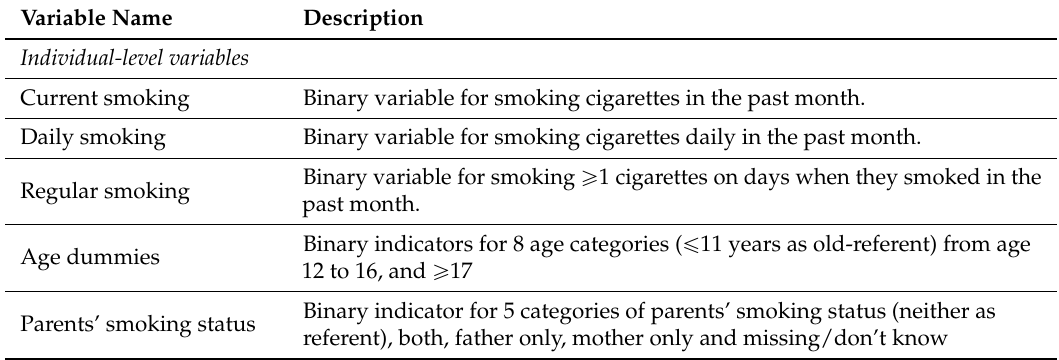
Table 1. Variable definition: Individual-level smoking outcomes and demographic